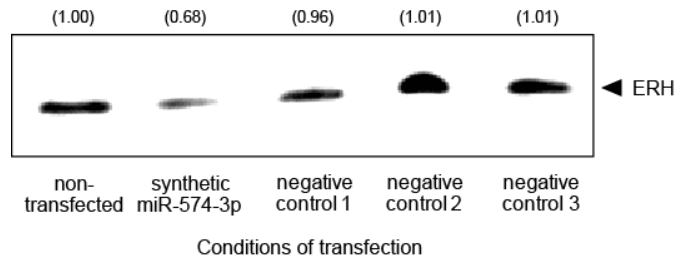
Figure 6. Downregulation of ERH in A549 cells overexpressing miR-574-3p. ERH protein in A549 cells transfected with synthetic miR-574-3p was detected by western blot analysis. The relative expression levels of the ERH protein in the cells are quantified and indicated in the panel.